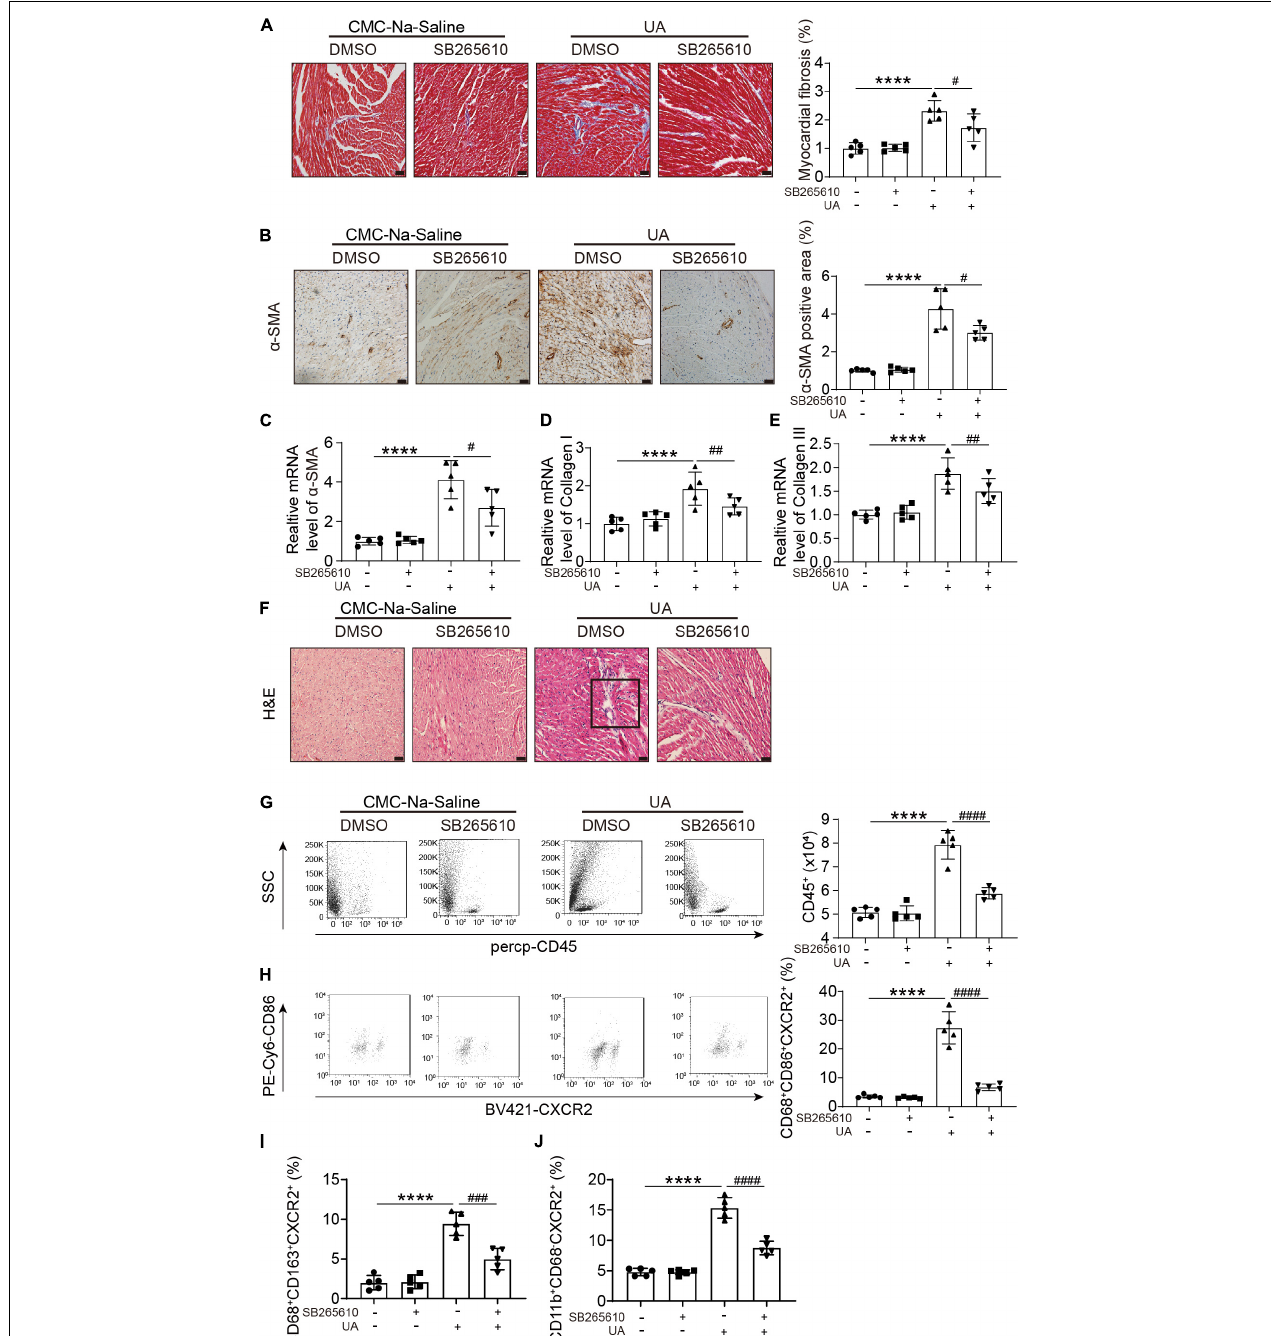
FIGURE 3 | CXCR2 antagonist abolished UA-induced cardiac inflammatory responses and fibrosis. Representative images of Masson’s staining of hearts from mice subjected to CMC-Na-saline or UA, with or without CXCR2 antagonist at day 14 (A) . The percentage of the fibrotic area was analyzed in the right panel. Representative images of IHC staining of alpha smooth muscle actin ( α -SMA) on hearts sections from mice subjected to CMC-Na-saline or UA, with or without CXCR2 antagonist treatment at day 14 (B) . The percentage of positive staining area was analyzed in the right panel. mRNA levels of α -SMA, collagen I, and collagen III in hearts in mice subjected to CMC-Na-saline or UA, with or without CXCR2 antagonist at day 14 (C–E) . Representative images of H&E staining of the hearts from mice subjected to CMC-Na-saline or UA, with or without CXCR2 antagonist at day 14 (F) . Representative images of flow cytometry displaying infiltrated leukocytes, determined by CD45-positive cells in the hearts from mice subjected to CMC-Na-saline or UA, with or without CXCR2 antagonist treatment (G) . Quantitation of infiltrated leukocytes in hearts is shown in the left panel. Representative images of flow cytometry displaying CXCR2 + M1 macrophages, determined by CD45 + /CD68 + /CD86 + /CXCR2 + cells relative to the whole population of CD45 + /CD68 + /CD86 + cells in the hearts from mice subjected to CMC-Na-saline or UA,